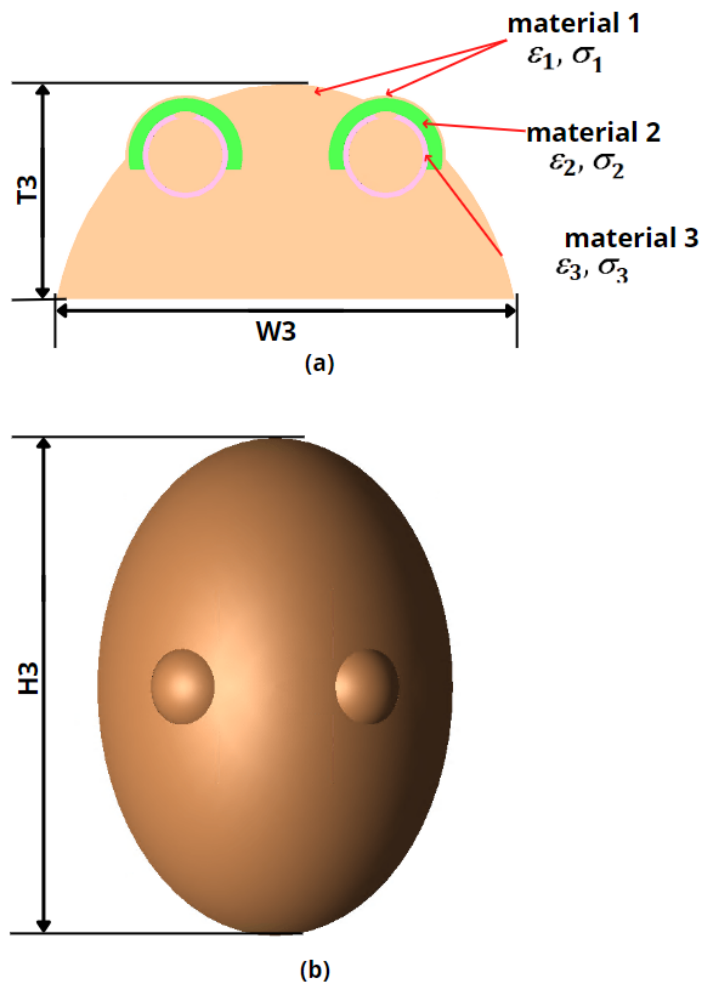
Figure 5. Simplified model of a human face. ( a ) Horizontal plane cross-section at the level of the eyeballs. ( b ) Front view of the face.